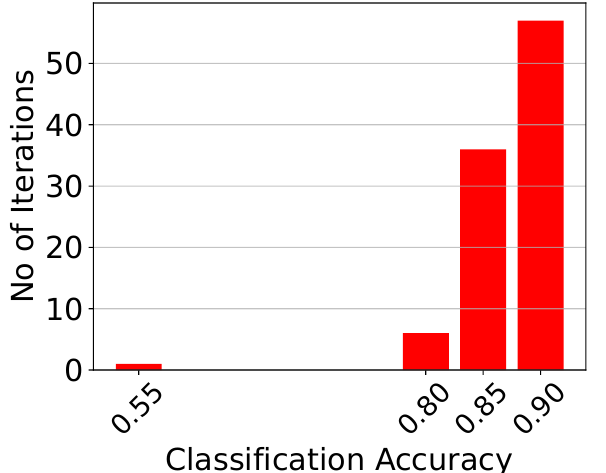
Figure 16. Monte Carlo histogram of the analog centroid-based classifier attached to the first electrode for N = 100